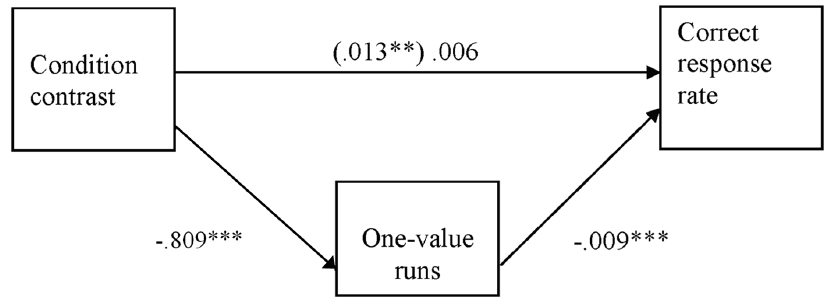
Figure 6. One-value runs as a mediator between condition contrast (random-only vs. all other conditions) and correct response rate (Experiment 3). All coefficients are unstandardized. The coefficient in parenthesis does not control for the effect of one-value runs. ***p ,